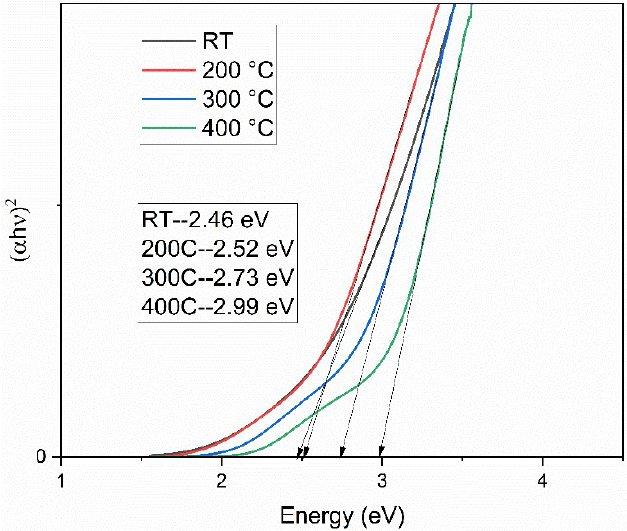
Figure 6. Tauc plots of the CuInO x thin films deposited at different substrate temperatures.